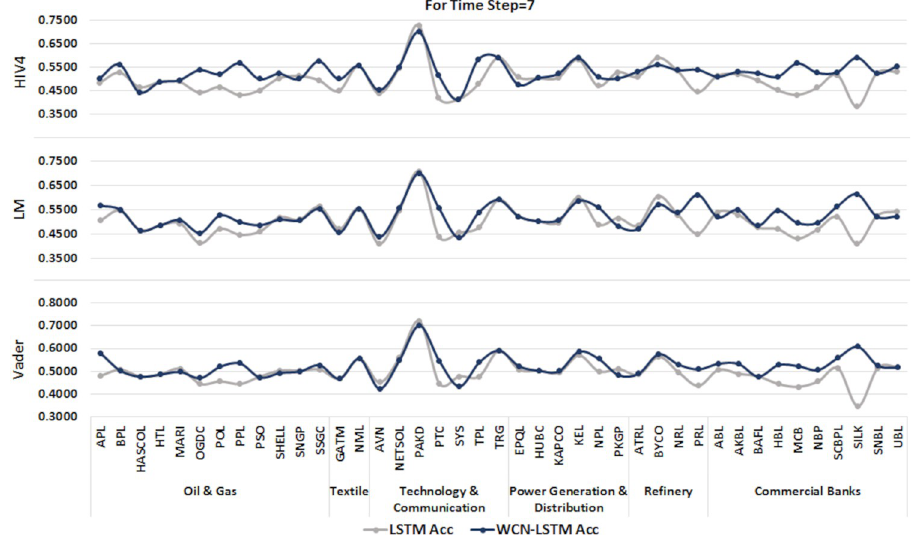
Fig 6. Accuracy of prediction models by incorporating information from the last 7 days using the test set.